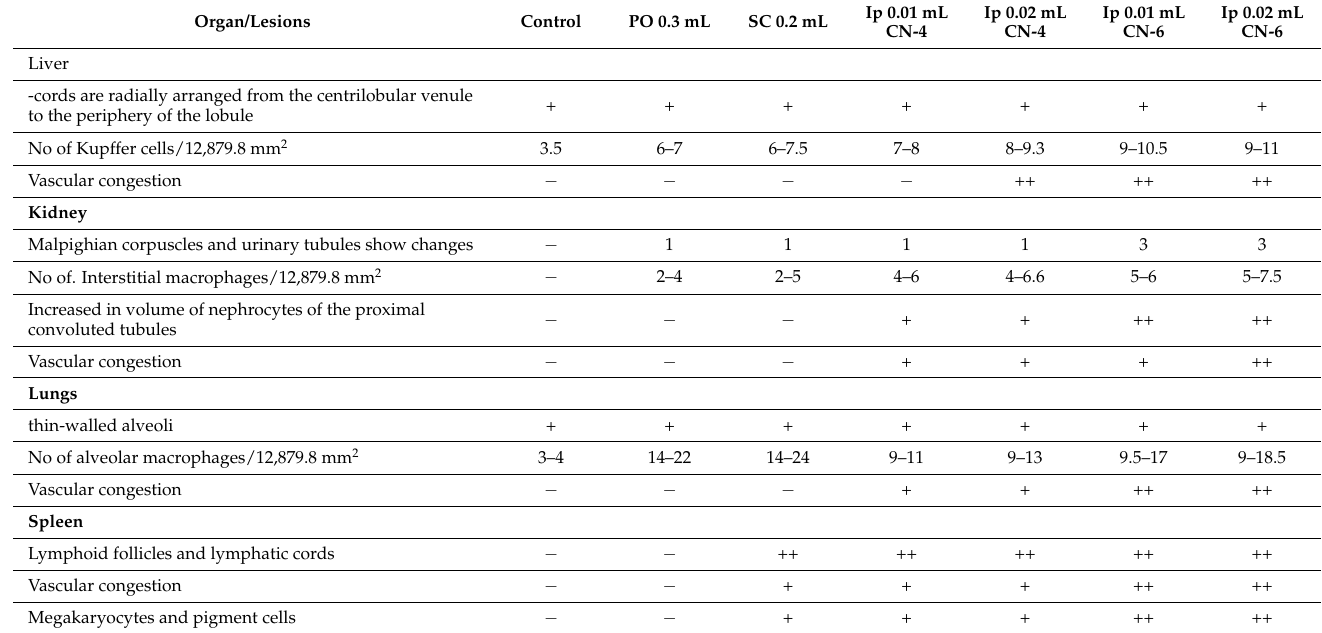
Table 5. Assessment of cellular and vascular changes produced in the organs under study.